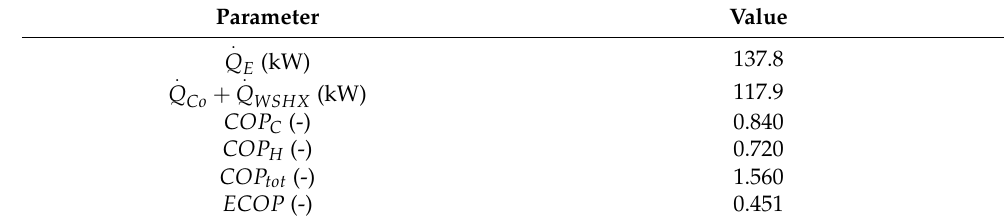
Figure 15. Working temperatures and flow rates for the hybrid air conditioning system. Table 6. Absorption heat pump performance for the hybrid air conditioning system.